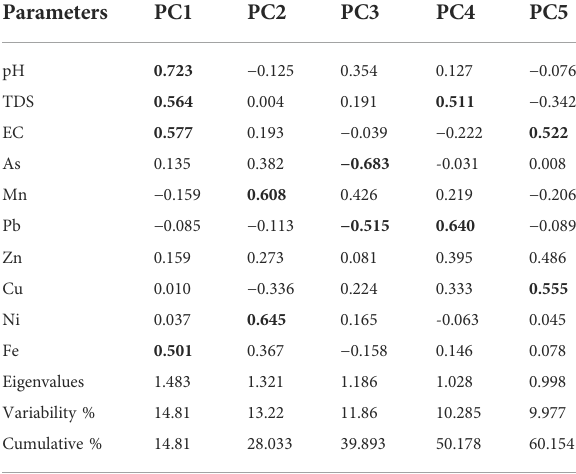
TABLE 2 Principal component analysis of groundwater samples collected from the study area.